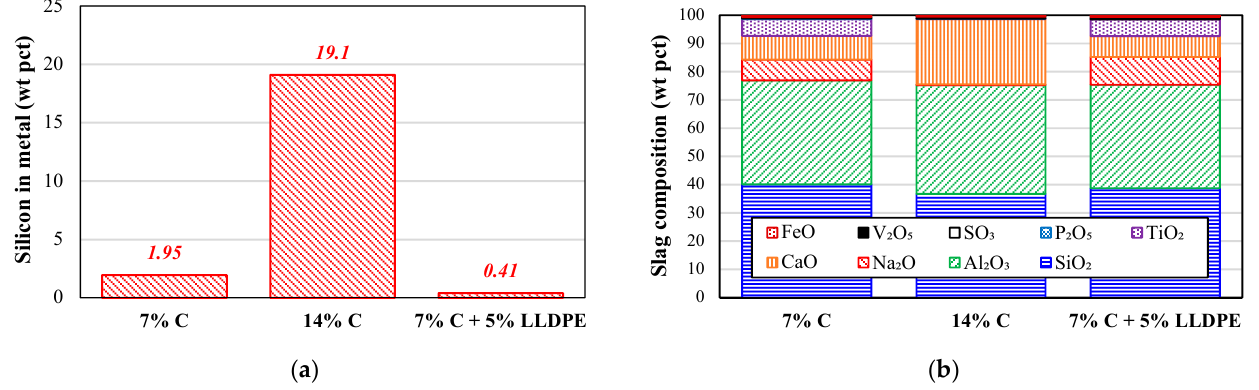
Figure 5. The effects of carbon and LLDPE additions at T = 1450 °C and t = 60 min on: ( a ) Silicon in metal; and ( b ) Composition of slag.